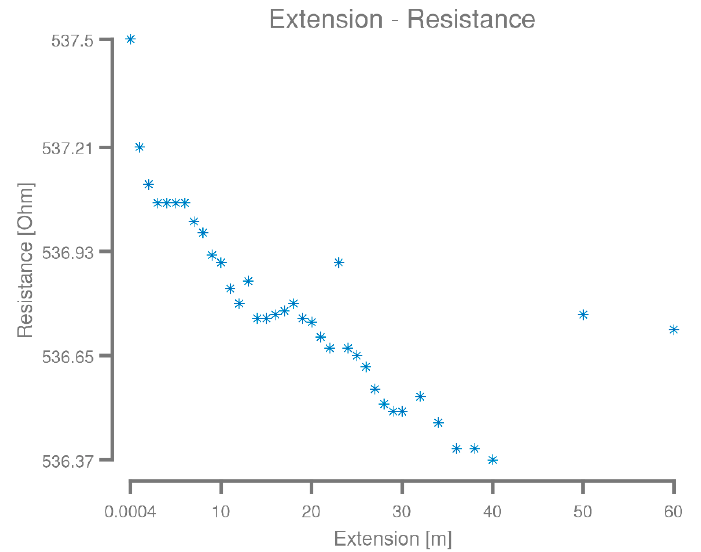
Figure 7. The resistance of the 66.6 m long meander plotted as a function of its extension. A noticeable, but procentual small drop in resistance was observed as the meander was extended, most likely due to the copper folding back on itself at each arc, which would slightly reduce the electric path length when stretching the